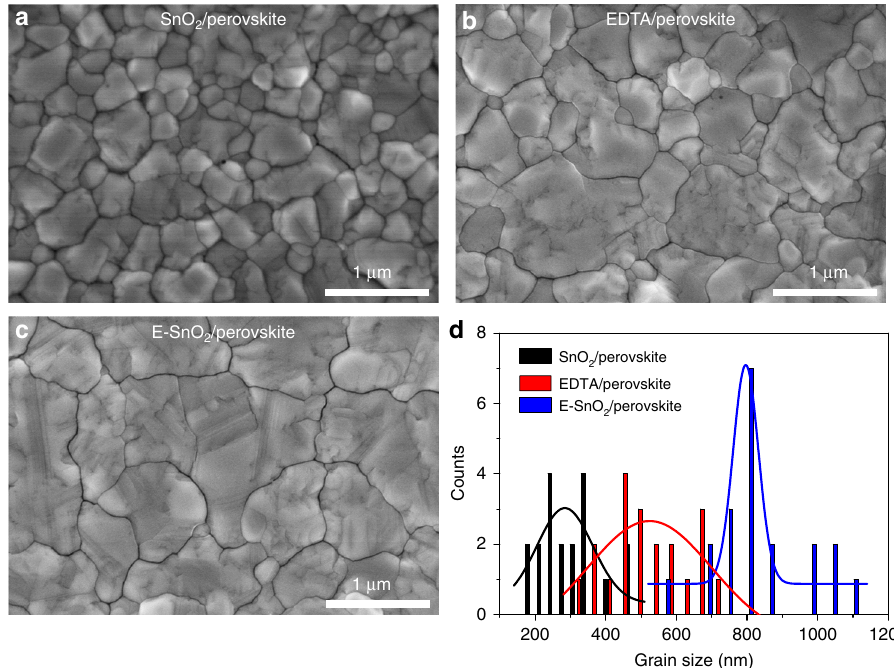
Fig. 2 The morphology of perovskite fi lms deposited on different substrates. Top-view scanning electron microscope (SEM) images of perovskite fi lms coated on a EDTA, b SnO 2 , and c E-SnO 2 substrates. d The grain size distribution of perovskite deposited on various